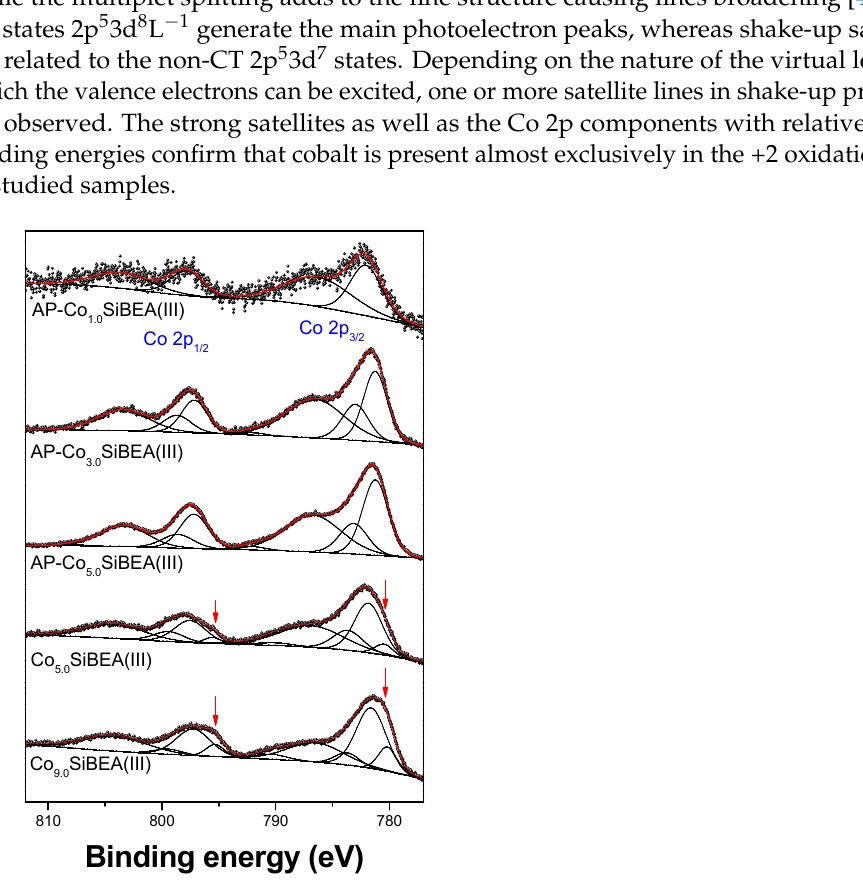
Figure 9. Co 2p XPS spectra of Co x SiBEA (pH = 2.5). Red arrows mark a low-BE component which is not seen in as received samples.